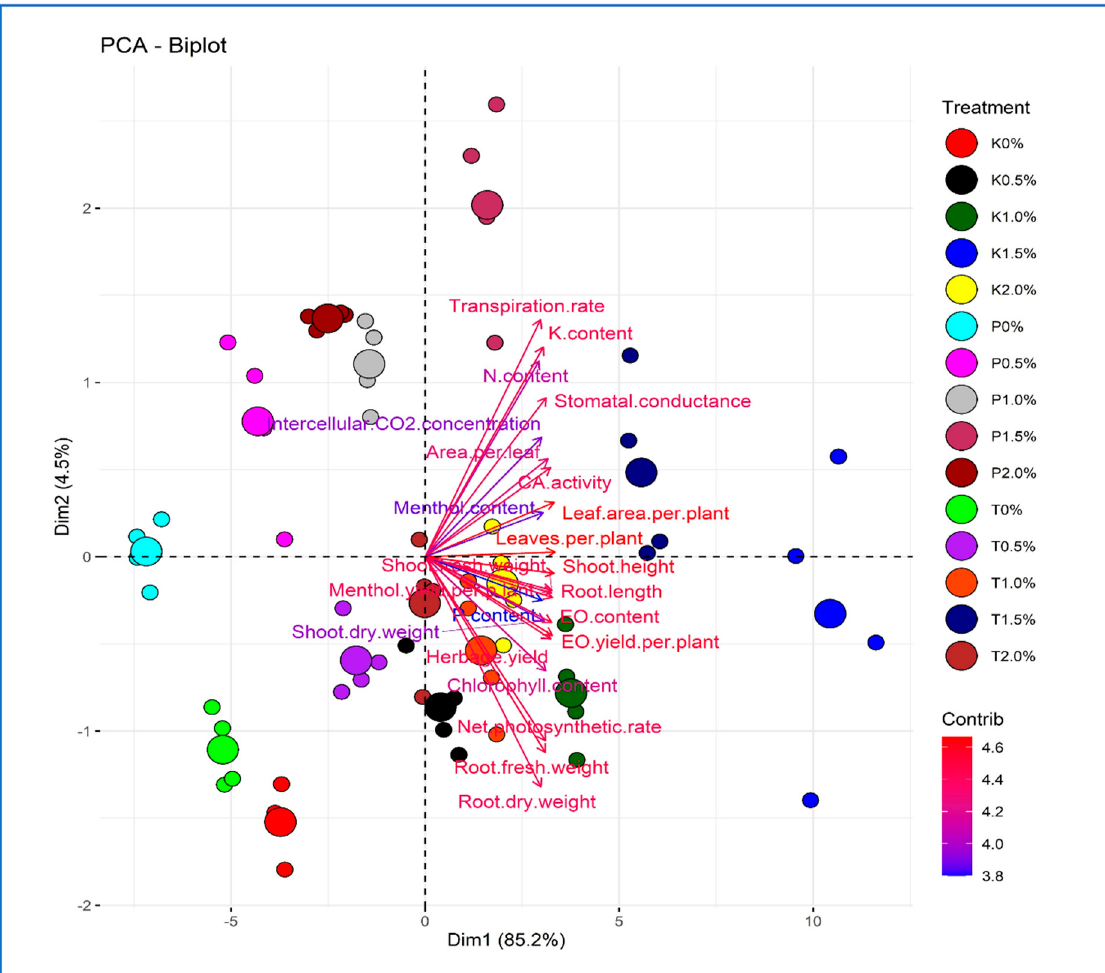
Figure 14. PCA-biplot depicting the interaction effect of three cultivars and different N treatments. K0%–K2%: cultivar Kukrail at different concentrations of P0%–P2%; cultivar Pranjal at different concentrations of T0%–T2%; cultivar Tushar at different concentrations of %N.